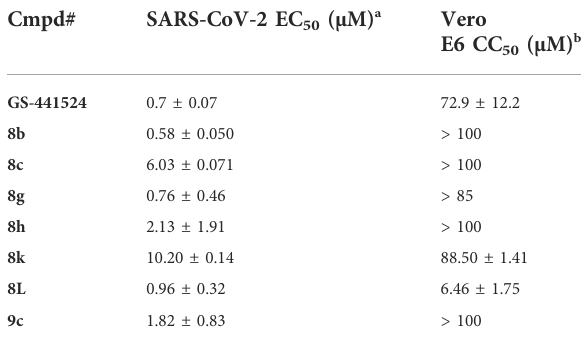
TABLE 7 AAK1 inhibition. TABLE8Anti-SARS-CoV-2activityandcytotoxicityofselected5-aryl- 3-alkynyl-pyrrolo[2,3- b ]pyridines.